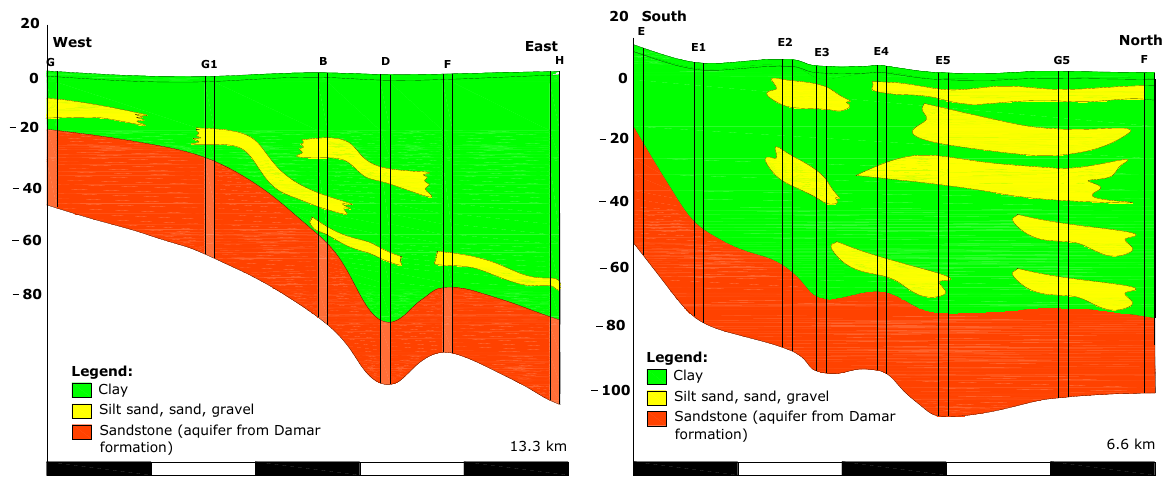
Figure 4. Lithological sections of Semarang City. Source of lithological section: Marsudi [31]. Hydrologically, Semarang City is divided into 6 watersheds from west to east. They are Blorong, West Mangkang (Mangkang Barat), East Mangkang (Mangkang Timur), Garang, East Kanal (Kanal Timur), and Babon. There are four major rivers flowing in Semarang City: the Mangkang Barat/West Mangkang River, Mangkang Timur/East Mangkang River, Garang River, and Canal Timur/East Canal River. As other cities in Indonesia, Semarang City has two distinct seasons, i.e., the dry season and the wet (rainy) season. The dry season lasts from April to September, while the period from October to March is the rainy season. The mean annual temperature and humidity in Semarang City are 28.08 °C and 76.61%, respectively. The annual rainfall in Semarang City varies from 1500 to 3000 mm. The rainfall during the wet months is a source of groundwater recharge [36], but the heavy rainfall frequently causes problems of river overflow and flooding. 2.3. Groundwater Modeling Geophysical experiments are usually conducted to explore the formation of groundwater system. Therefore, a wide range of data related to pumping operations and soil parameters is required, which makes it expensive and time-consuming. Groundwater numerical modeling holds great promise for a better understanding of the groundwater system and an effective implementation of groundwater management. Numerical modeling can provide an accurate, quantitative description of groundwater behaviors, which can serve as the guidance and professionalism for structuring better strategic management. MODFLOW is a computer program for three- dimensional modeling of groundwater movement through porous materials [37]. The first MODFLOW program was documented and written in FORTRAN ’66 [38] by the United States Geological Survey (USGS). In the early 1990s, MODFLOW had been widely used all over the world since then. In the early 2000s, some additions were made for estimating transport parameters. MODFLOW-2000 possesses the features and capabilities of the groundwater flow and transport, as well as parameter estimation functionality [39] with integration of user-friendly interfaces. According to Darcy’s Law, three-dimensional groundwater movement can be described by the partial differential equation as follows [38]: 𝜕 𝜕𝑥 (cid:3436)𝐾 (cid:3051)(cid:3051) 𝜕ℎ 𝜕𝑥(cid:3440) + 𝜕 𝜕𝑦 (cid:3436)𝐾 (cid:3052)(cid:3052) 𝜕ℎ 𝜕𝑥(cid:3440) + 𝜕 𝜕𝑧 (cid:3436)𝐾 (cid:3053)(cid:3053) 𝜕ℎ 𝜕𝑧(cid:3440) − 𝑊 = 𝑆 (cid:3046) 𝜕ℎ 𝜕𝑡 (1) where: x , y , z = Cartesian coordinates in x , y , and z directions;